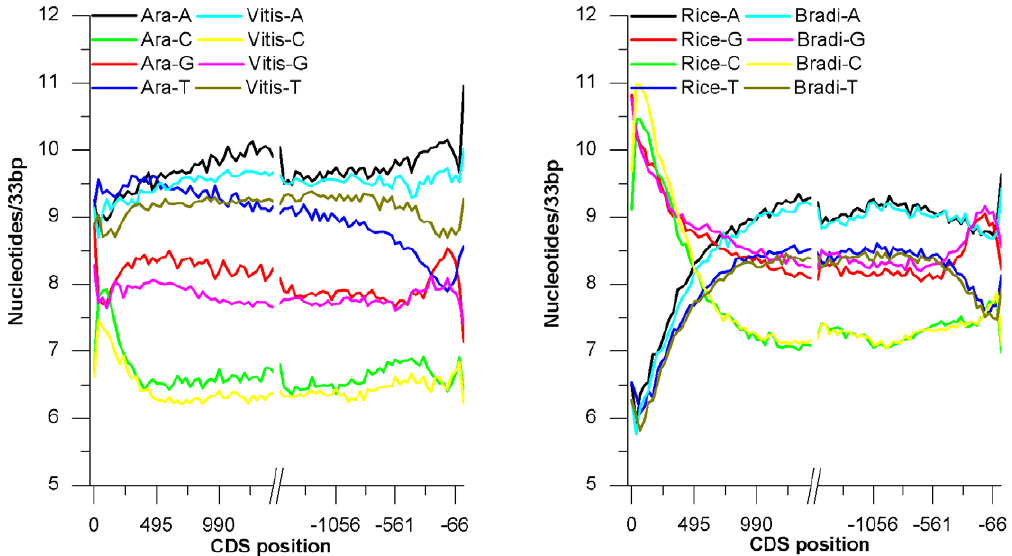
Figure 1. Mononucleotide content of CDS. Overall mononucleotides content as function of position in eudocots ( Vitis and Arabidopsis ) and monocots ( Oryza and Brachypodium ) coding sequences and averaged over all sequences in the dataset with a 33 bp adiacent window.